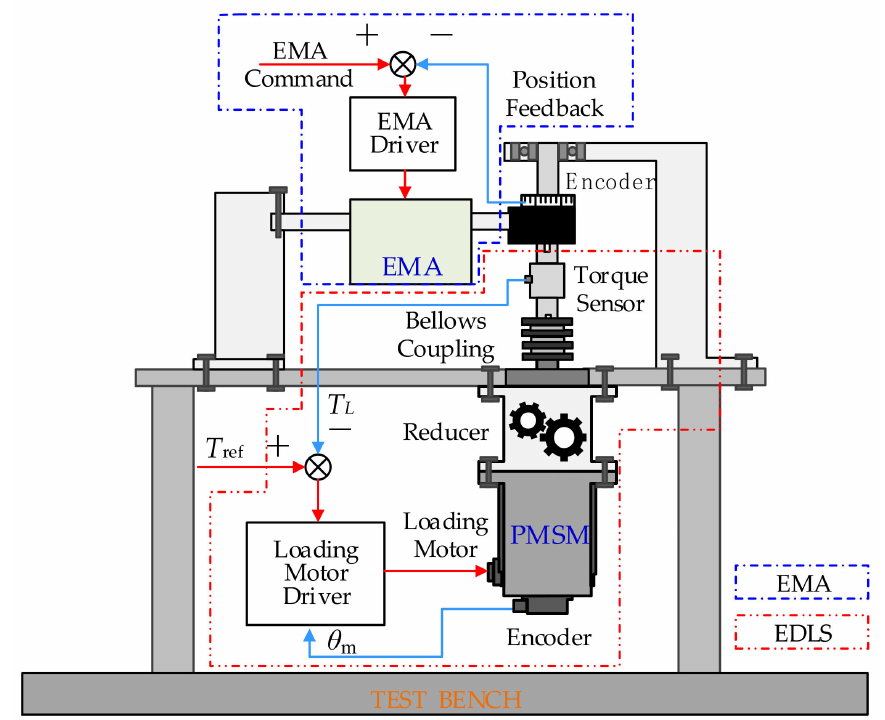
Figure 1. Electrical dynamic load simulator system